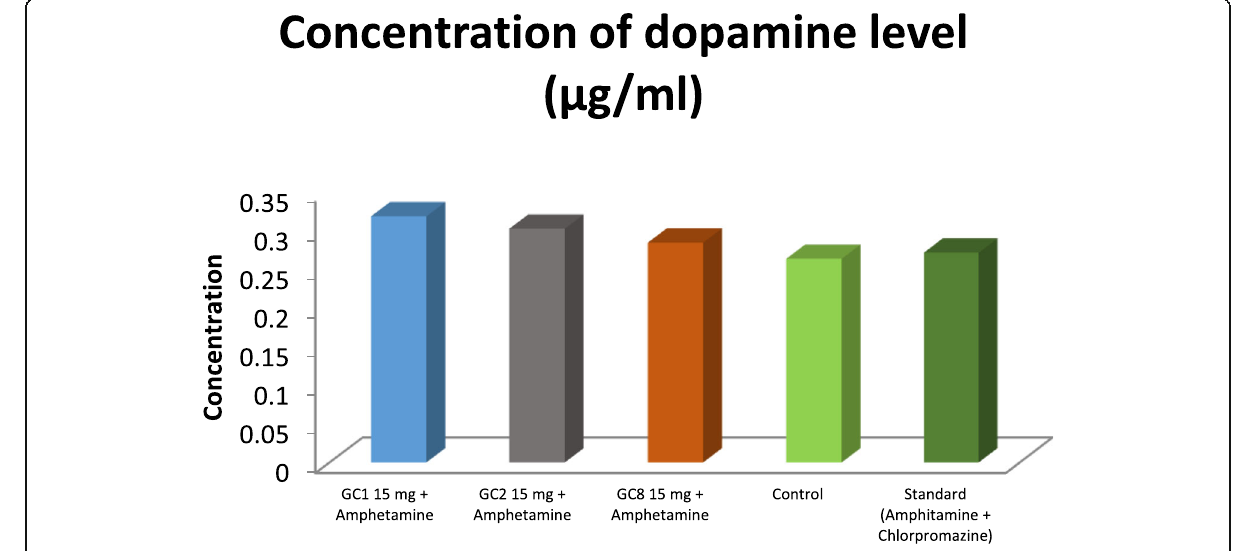
Fig. 6 The concentration level of dopamine in the separated brain after being co-administered of synthesised compounds/chlorpromazine and